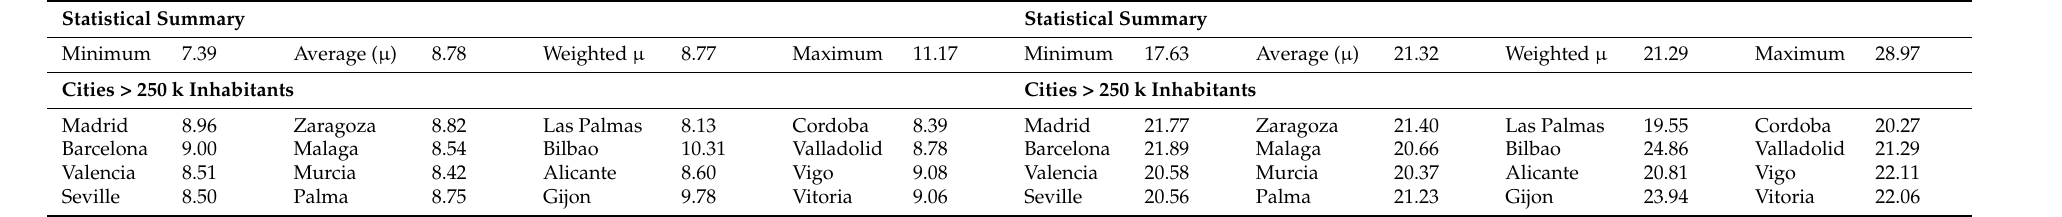
Figure A3. ST PB in years (S3 (auxiliary electricity supply scenario) left , and S4 (auxiliary natural gas supply scenario) right ).